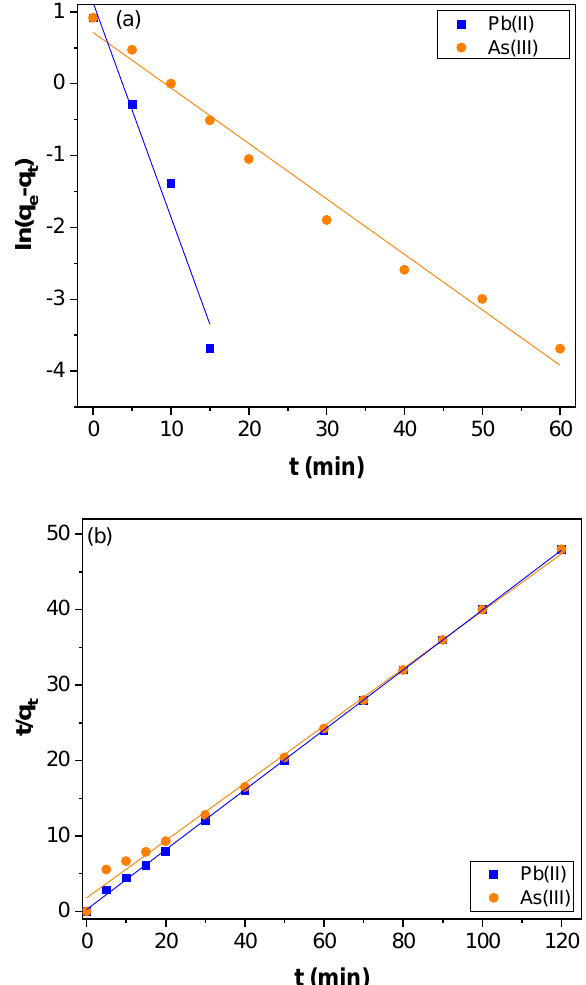
Figure 8. ( a ) Pseudo-first-order and ( b ) pseudo-second-order kinetics for Pb(II) and As(III) adsorption over CNTs–PAMAM–Ag. Nanomaterials 2022 , 12 , x FOR PEER REVIEW